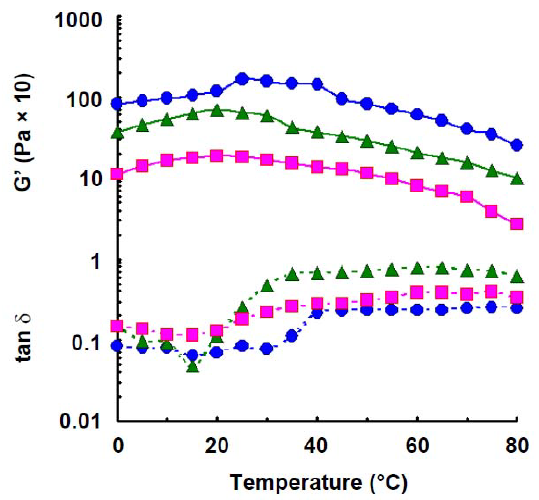
Figure 3. Effect of temperature on the elastic modulus and tan δ of wheat amylose at various concentrations. Concentrations: 1.2%, ■; 1.4%, ▲; 1.6%, ●. Lines: storage modulus, solid; tan δ, dotted.